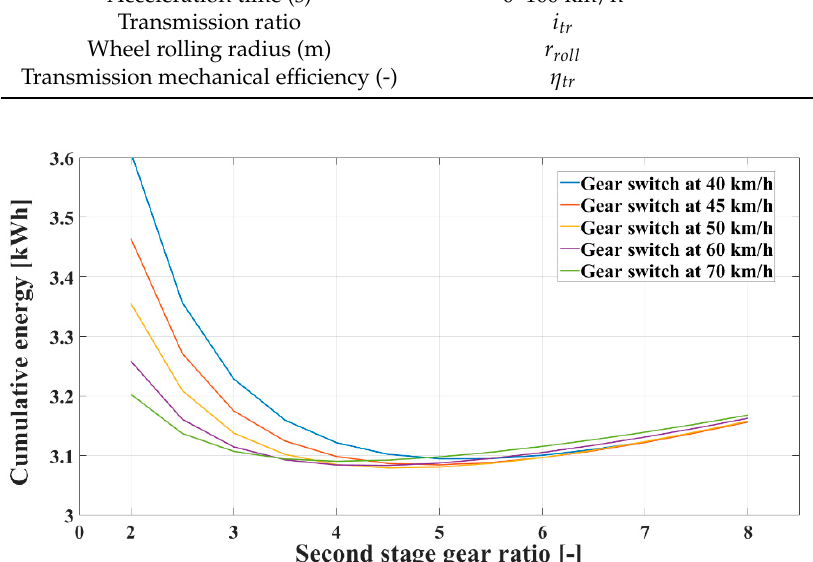
Figure 6. Cumulative energy consumption vs. transmission second gear ratio for different switching speed over